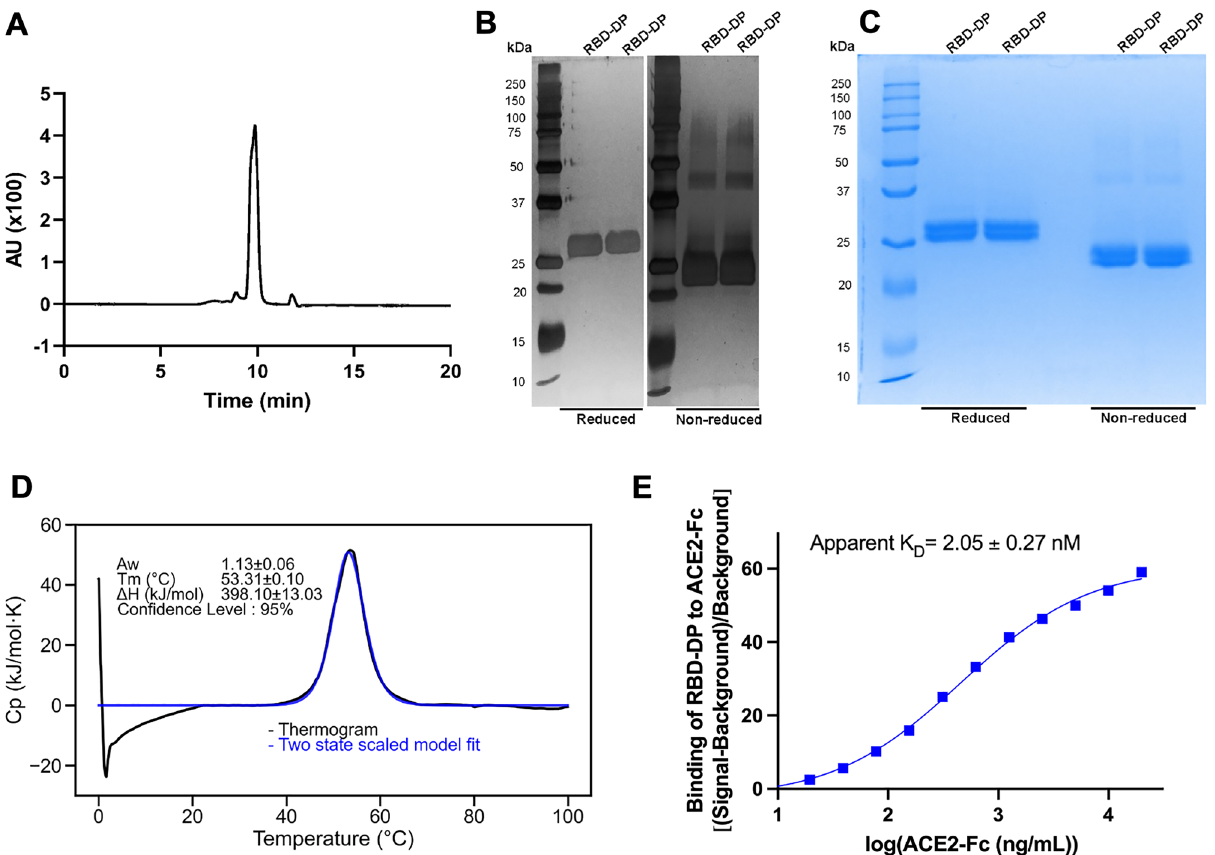
Figure 3. Characterization of the purified RBD-DP. ( A ) SE-UPLC chromatogram. ( B ) Silver stained SDS-PAGE of reduced/non-reduced RBD-DP. ( C ) Coomassie stained SDS-PAGE of reduced/non-reduced RBD-DP. ( D ) Differential Scanning Calorimetry (DSC) profile showing thermal melt of 53.31 ± 0.10 °C. ( E ) Determination of binding affinity of RBD-DP to ACE2-Fc by